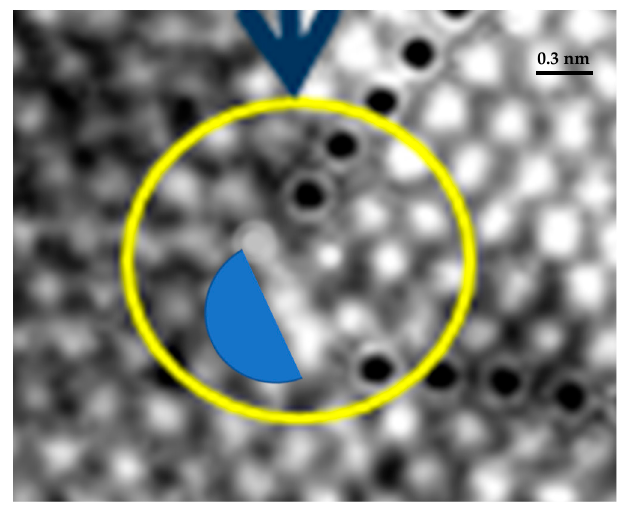
Figure 11. Enlargement of Figure 3c showing the dislocation region. Materials 2019 , 12 , x FOR PEER REVIEW